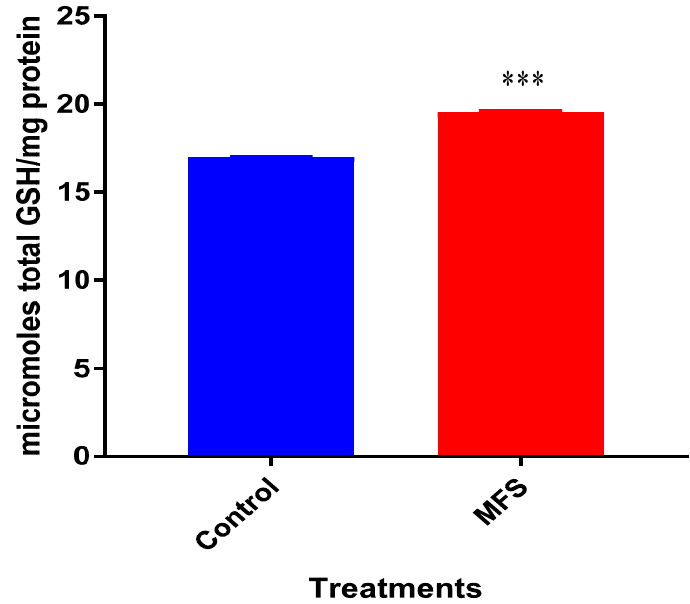
Figure 5. Levels of total Glutathione (GSH) in untreated and MFS-treated THP-1 cells. Corrections were made to total protein measured by BCA Protein Assay Kit from Thermo Scientific. Data represent means ± SE from 6 trials. *** p < 0.0005 when comparing GSH levels from control and MFS treated groups.